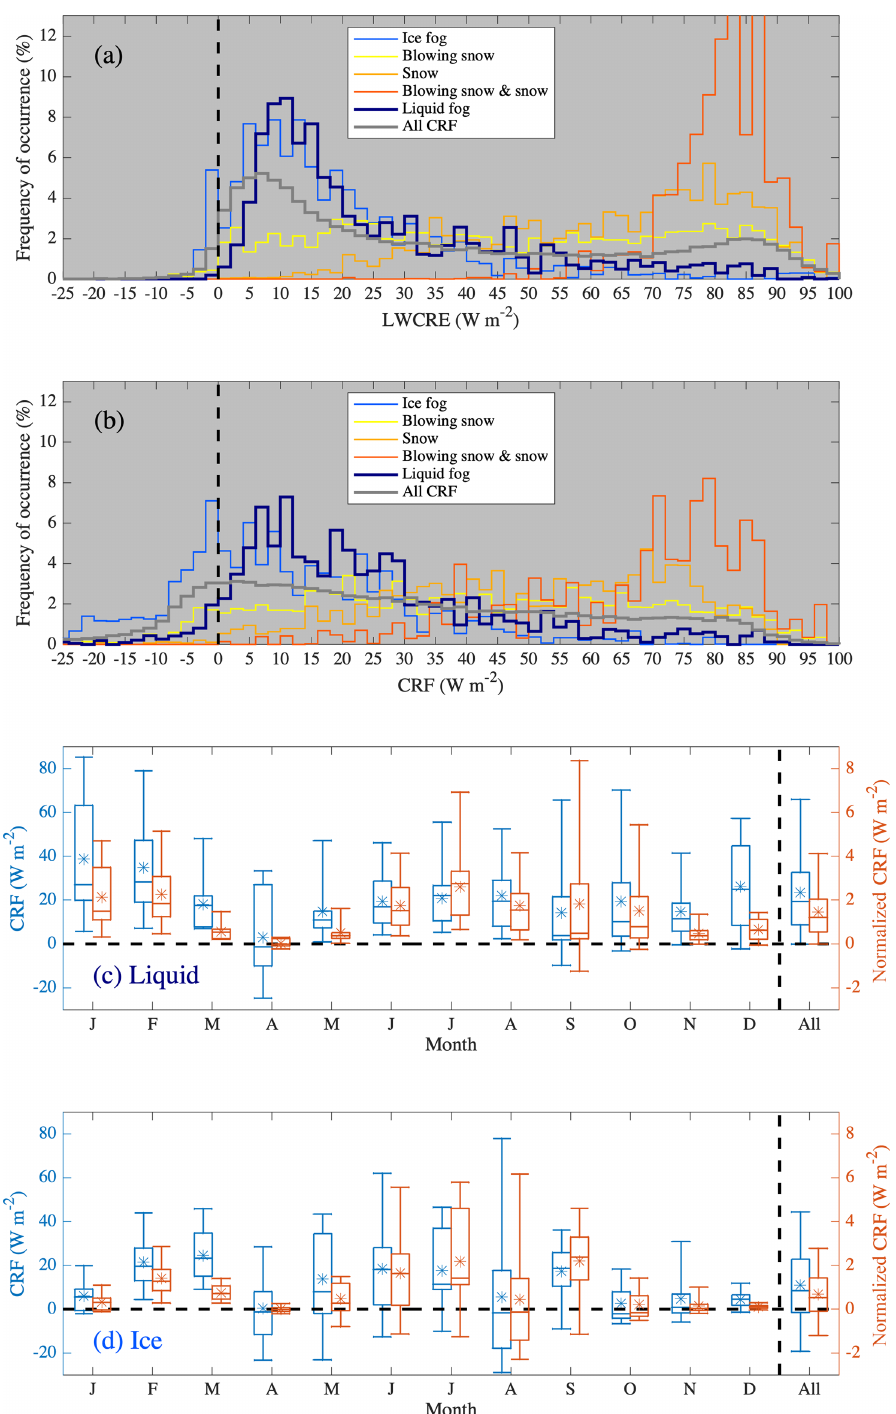
Figure 13. Distributions for all seasons for classified data types of (a) longwave cloud radiative effect (LWCRE), defined as the perturbation to the downwelling longwave radiation (LWD) caused by clouds, LWD – LWD clear-sky ; (b) Cloud radiative forcing (CRF); (c) For just liquid fog classifications, box and whisker plots ( ∗ = mean, boxes are 25th, 50th, and 75th percentiles, whiskers are 5th and 95th percentiles) for each month for CRF of identified cases (blue) and CRF normalized by frequency of occurrence of liquid fog (red). Panel (d) as in panel (c) but for the ice fog